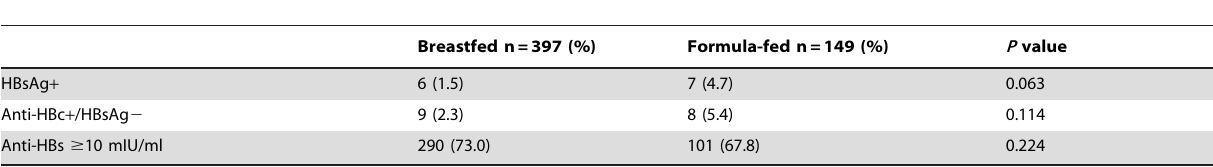
Table 2. HBV serologic markers in breast- and formula-fed children of HBsAg-positive